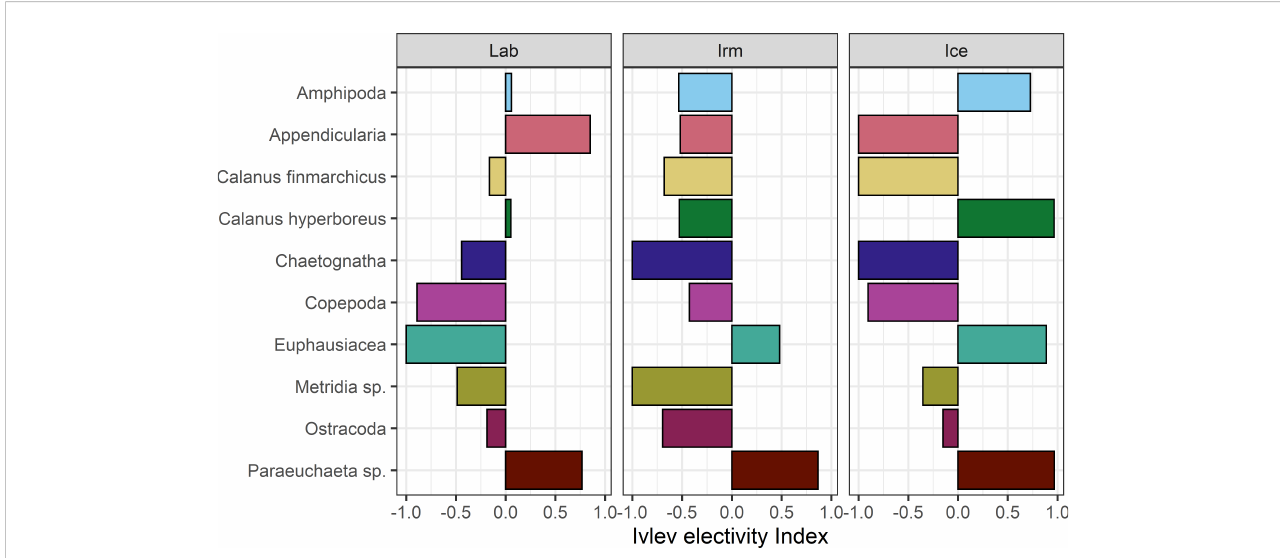
FIGURE 11 Ivlev ’ s electivity index calculated based on mean numerical abundance (number of prey items in stomach) for both length groups combined and compared to in situ density of zooplankton aggregated to the same taxonomic groups obtained from vertically strati fi ed MOCNESS samples. Negative index values re fl ect negative selection and positive values re fl ect positive